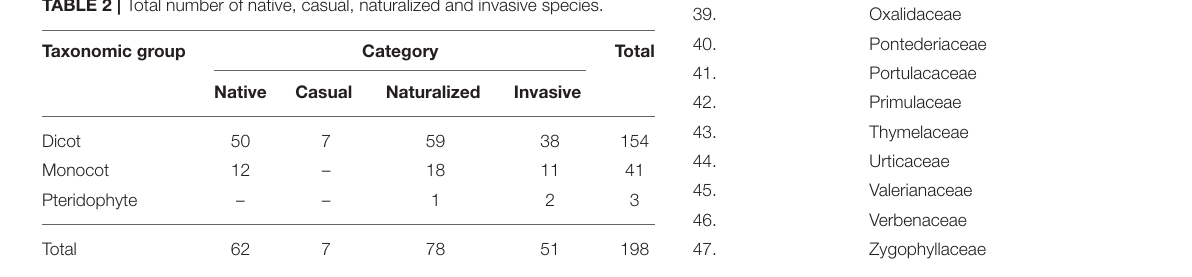
TABLE 2 | Total number of native, casual, naturalized and invasive